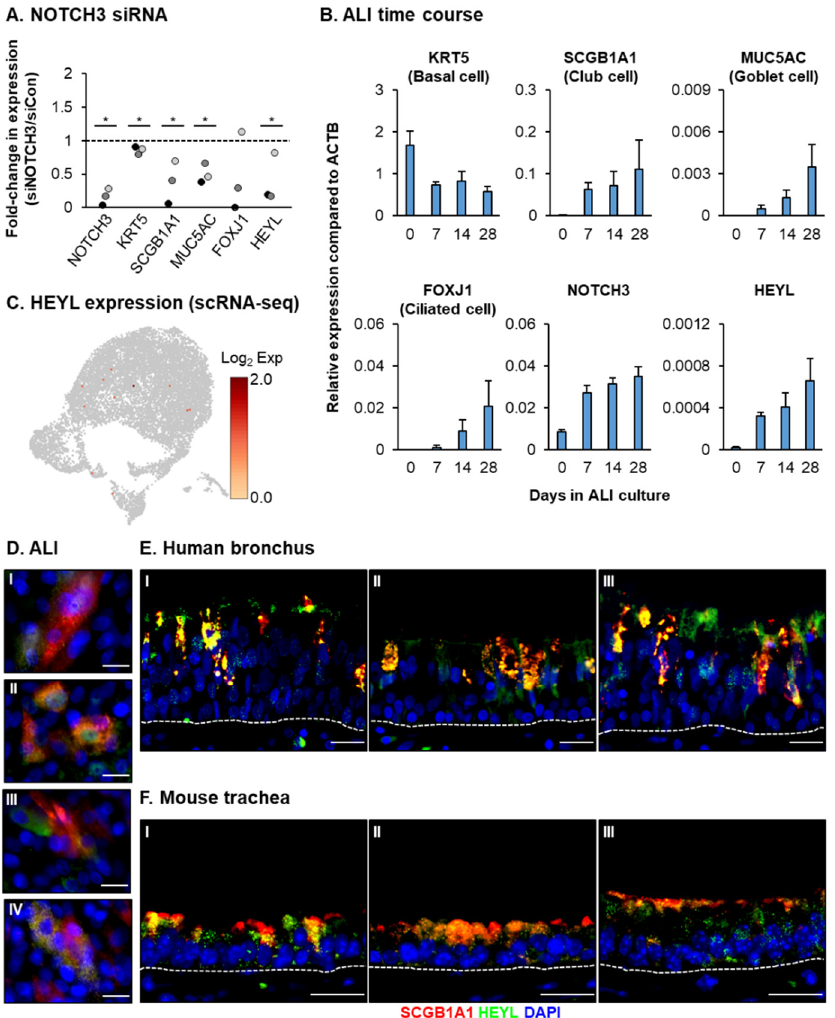
Figure 3. Expression of the NOTCH3 target HEYL correlates with mucociliary differentiation. ( A ) HBECs ( n = 3 normal, nonsmoker donors) were either transfected with control (siCon) or NOTCH3 (siNOTCH3) specific siRNA during seeding on ALI culture. On ALI day 7 the cells were harvested for qPCR analysis of NOTCH3, KRT5 (basal cell marker), SCGB1A1 (club cell marker), MUC5AC (goblet cell marker), FOXJ1 (ciliated cell marker) and HEYL. For each donor, the data are presented as fold-change in expression compared to siCon cells. * p < 0.05. ( B ) HBECs ( n = 5 normal, nonsmoker donors) were cultured on ALI for 28 days. The cells were harvested on ALI days 0, 7, 14 and 28 for qPCR analysis of KRT5, SCGB1A1, MUC5AC, FOXJ1, NOTCH3 and HEYL. Data presented as mean expression ( n = 5) at each time point. Error bars indicate SEM. ( C ) scRNA-seq analysis of HEYL expression in HBECs cultured on ALI for 9 days. ( D ) Immunofluorescent staining of SCGB1A1 (red), HEYL (green) and nuclei (blue, DAPI) in ALI day 7 cells. Four representative images ( I – IV ) are shown. Scale bar = 20 µm. ( E , F ) Immunofluorescent staining of SCGB1A1 (red), HEYL (green) and nuclei (blue, DAPI) in ( E ) human bronchus sections ( n = 3, donors, I – III ) and ( F ) mouse trachea ( n = 3 mice, I – III ). Scale bar = 20 µm. To test this hypothesis, HBECs were transfected with either control siRNA or HEYL specific siRNA and then cultured for 7 days on ALI. Compared to siRNA control trans- fected cells, HEYL expression was significantly suppressed (0.06-fold) in siRNA HEYL transfected cells (Figure 4A). Knockdown of HEYL led to changes in epithelial structure including significant reductions in TEER (Figure 4B), expression of tight junction-related genes (Figure 4C) and the proliferation markers MKI67 and PCNA (Figure 4D,E). Further- more, HEYL knockdown significantly impaired differentiation into club, goblet and cili- ated cells with a reduction in SCGB1A1 + (0.53-fold), MUC5AC + (0.84-fold) and FOXJ1 + (0.4-